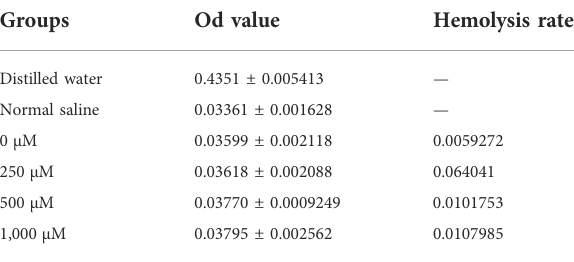
TABLE 2 OD values of Met/ α -CSH/nHA with different metformin concentrations.